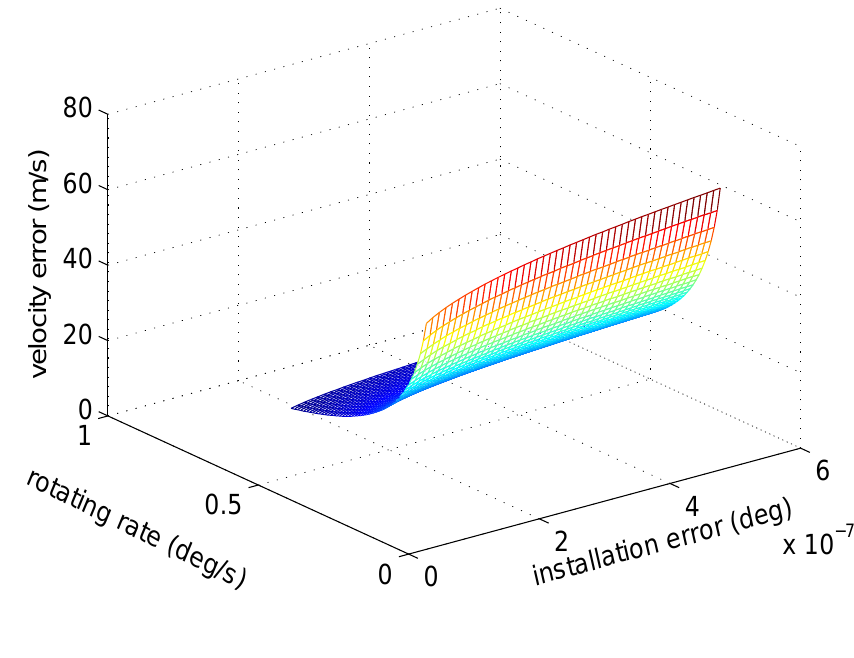
Figure 6. The relationship curve of the amplitude of the velocity error, the installation error and the rotating angular